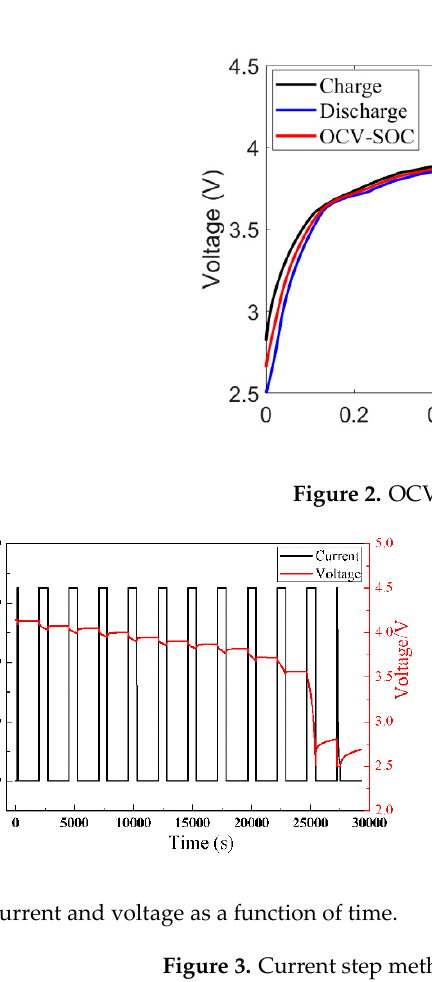
Figure 3. Current step method for model parameterization.